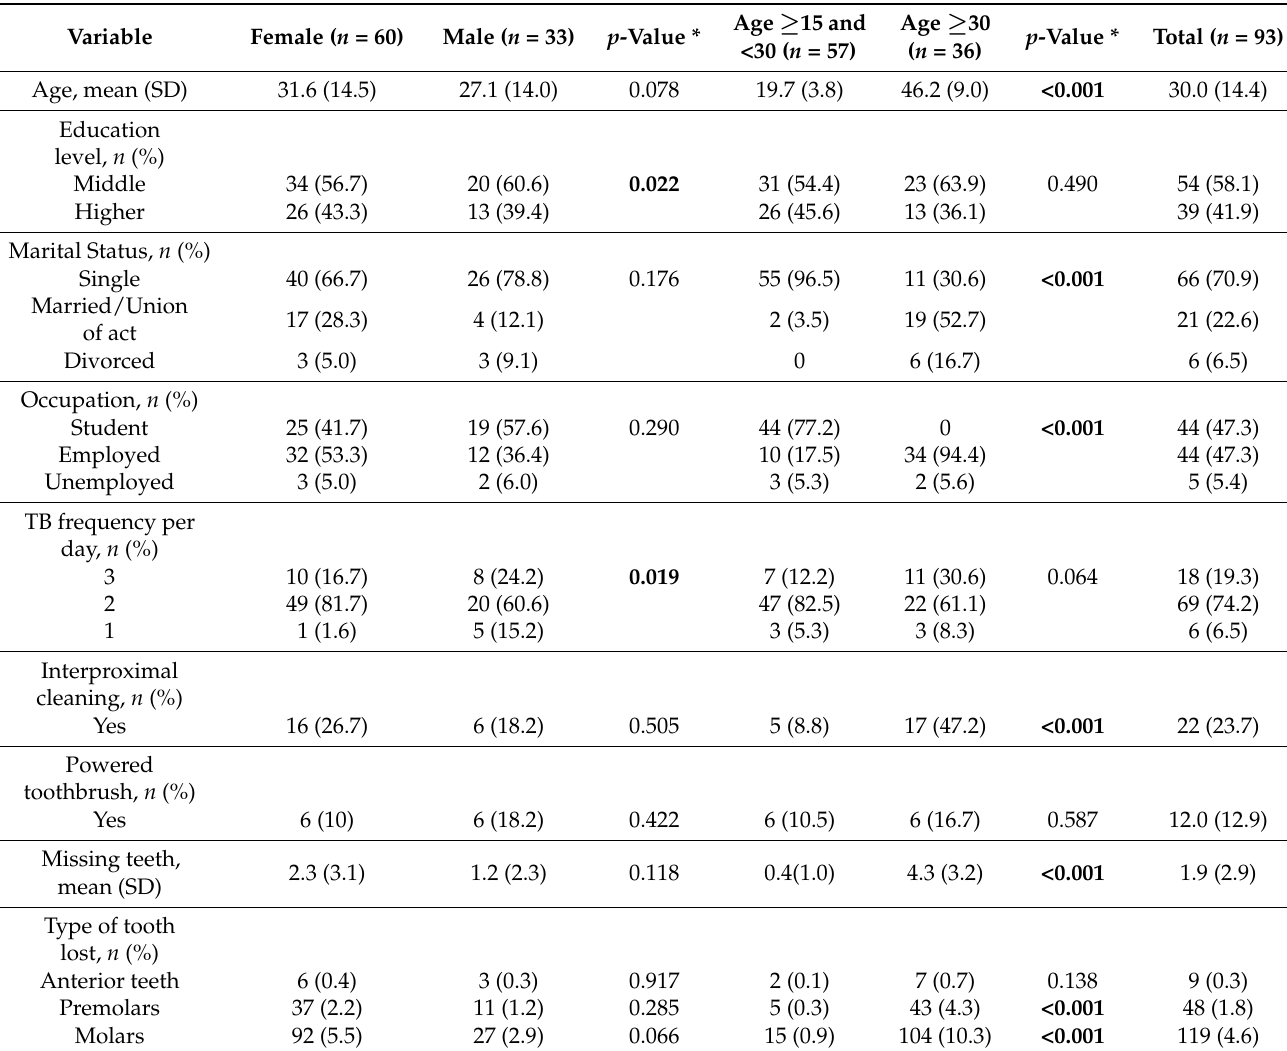
Table 1. Sociodemographic characteristics, oral hygiene variables and number of missing teeth, according to sex, age and for overall participants ( N =